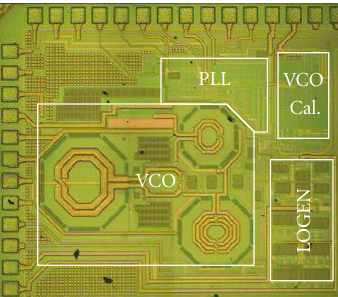
Figure 15: Chip micrograph of the ΔΣ fractional- N PLL synthesizer including only the VCO frequency calibration circuit